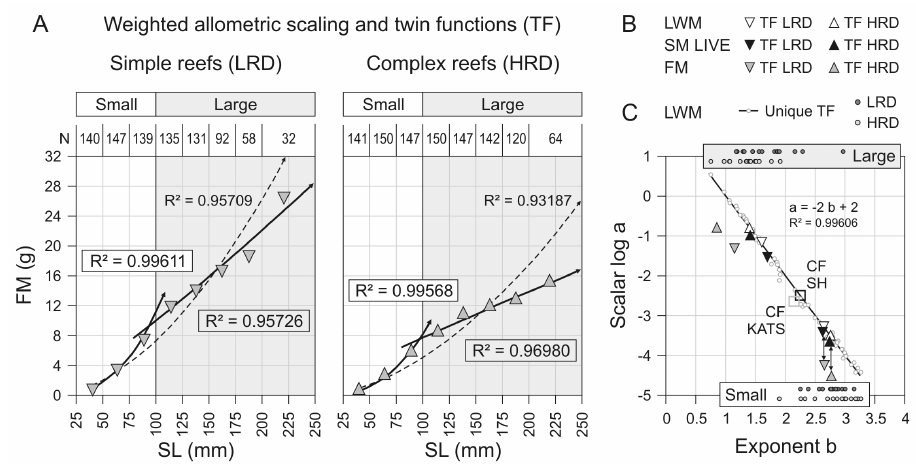
Figure 5. Oyster allometric scaling. A Determination of FM weighted TF. Plotted is FM (g) against SL (mm) of 8 SL classes after pooling individual metrics according to reef type (weighted). Displayed are powered relationships of all SL classes (broken line arrows), and of small and large oysters (TF) (black arrows). Given are coefficients of determination (R², FM weighted TF in boxes) and number of oysters per SL class (N). B Plotted are scaling parameters of LWM, SM LIVE and FM weighted TF (N = 12 equations, Table 2). Note similar exponents for small oysters (arrows). C Plotted are scaling parameters of all LWM TF per site and year (unique) (N = 30 small, N = 30 large). Exponential relationship